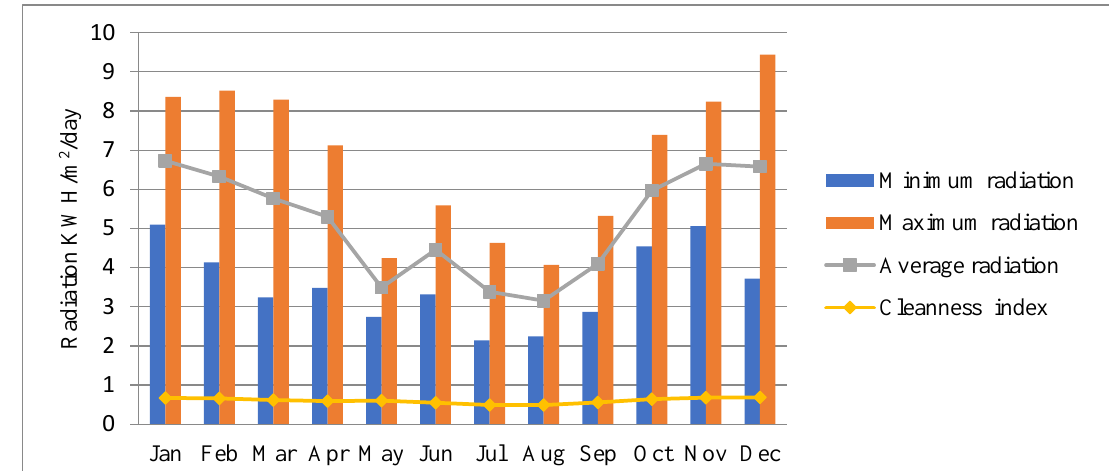
Figure 1. Solar radiation and cleanness index of North Shewa